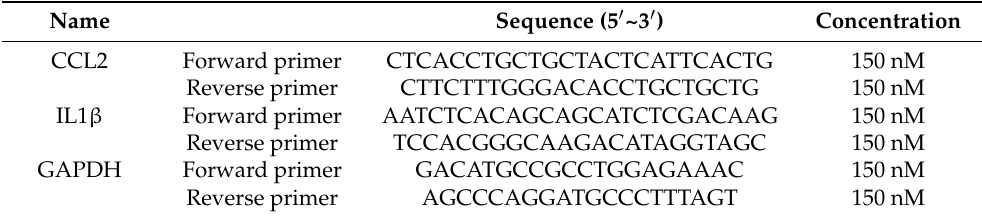
Table 4. Rat primers for quantitative real-time PCR analysis.